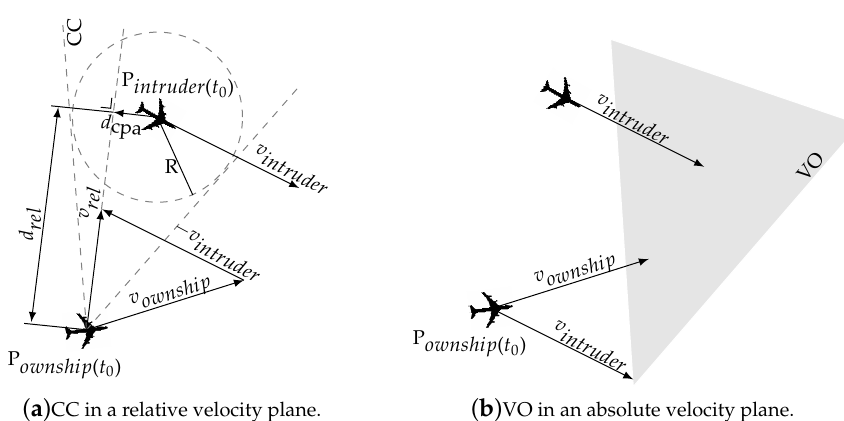
Figure 7. Cone of collision (CC) and a velocity obstacle (VO) in a situation of a future loss of separation. R represents the radius of the protected zone. P Ownship ( t 0 ) and P Intruder ( t 0 ) denote the ownship’s and the intruder’s initial position, respectively. v ownship is the observed aircraft velocity vector, v intruder is the intruder velocity vector, and v rel is the relative velocity vector. d rel is the relative distance vector, and d CPA indicates the distance at the closest point of approach.